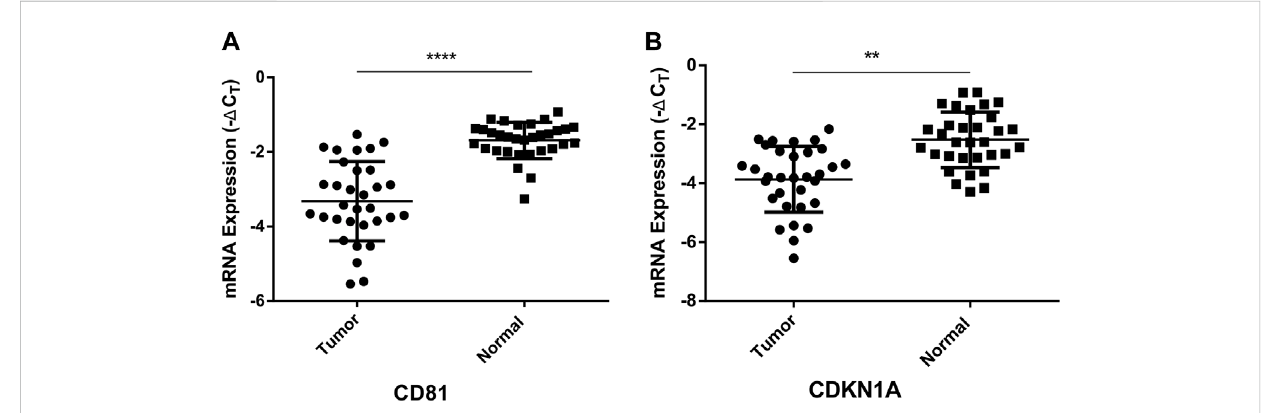
FIGURE 8 Quantitative real-time PCR analysis of the relative mRNA expression levels of CD81 (A) and CDKN1A (B) in tumor tissues as compared to adjacent normal tissues. ** p < 0.01, **** p <